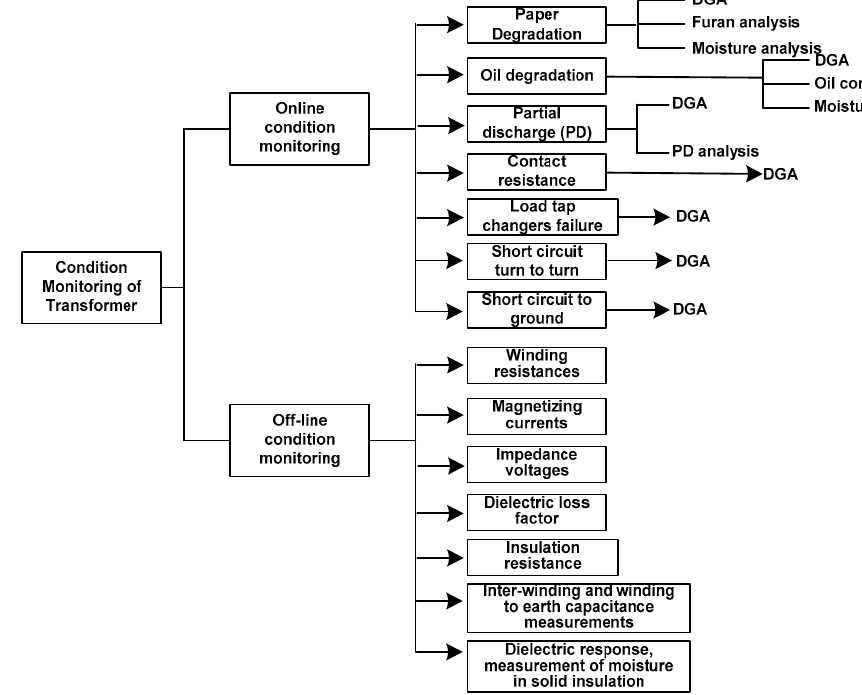
Figure 1. Different types of condition monitoring of transformers.